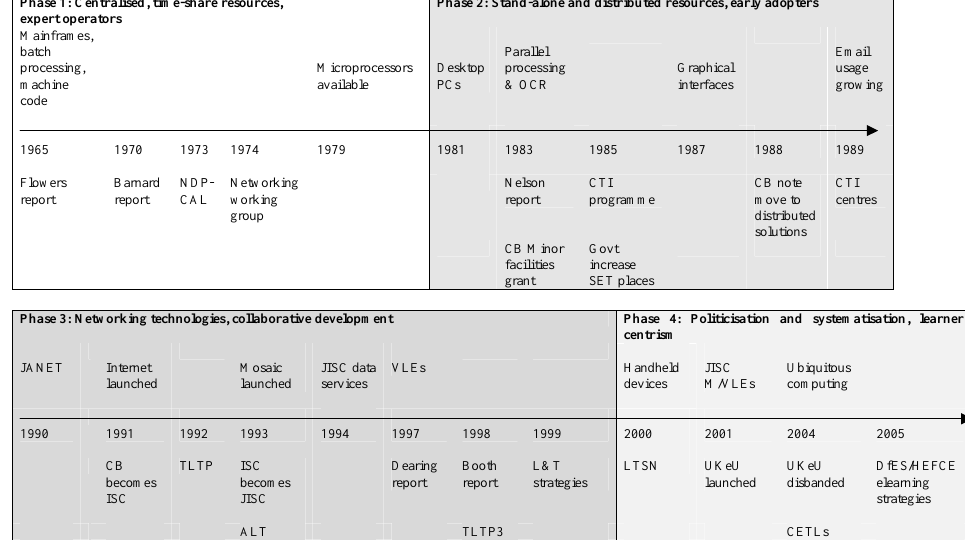
Figure 1. Timeline of technology and policy development in UK higher education